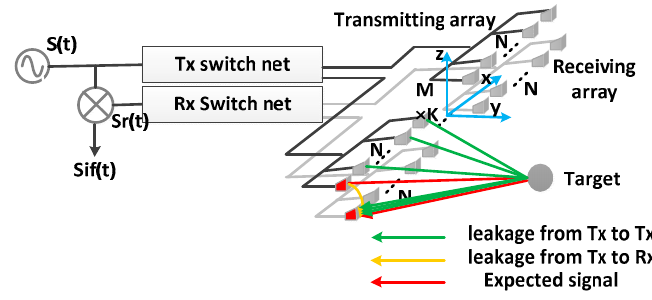
Figure 3. Signal path form Tx to Rx.